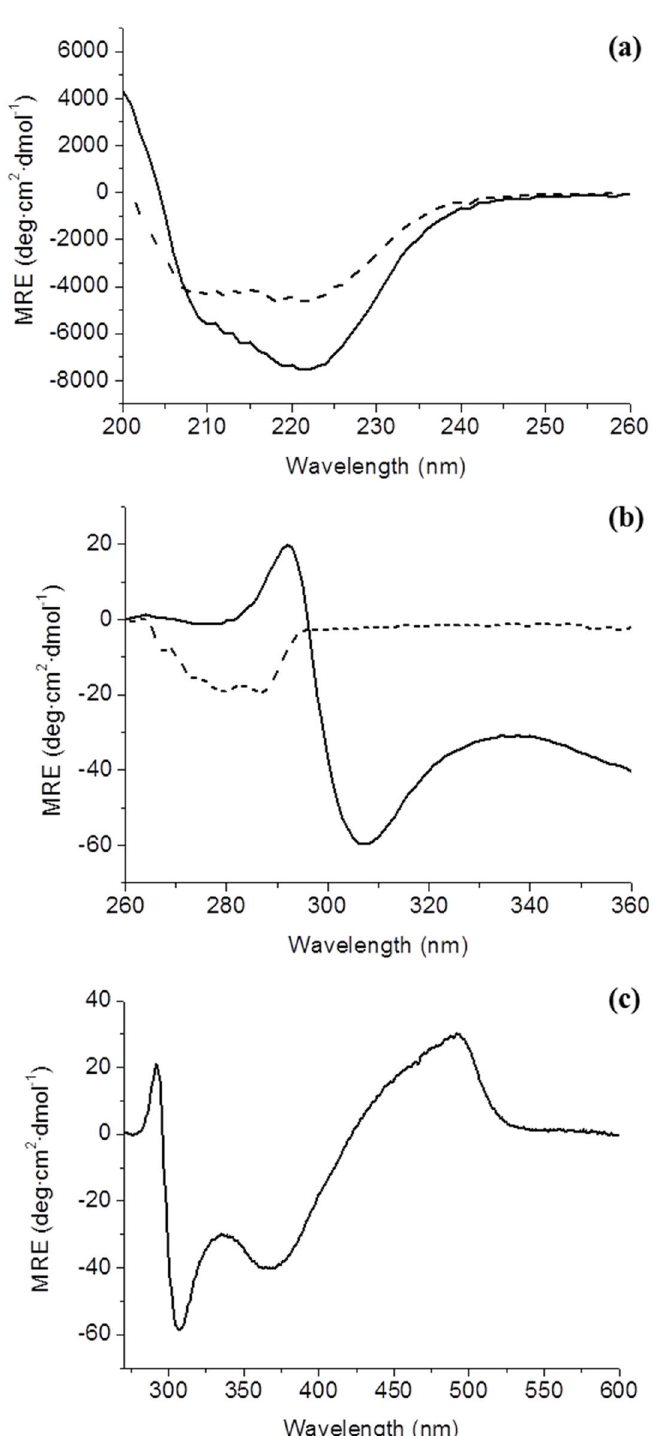
Fig 2. CD spectra of holo and apo Sp Fld in 150 mM NaCl, 100 mM MES, pH 6.5, 4˚C. (a) Far-CD spectra of 80 μ M of holo and apo Sp Fld (continuous and dashedlines respectively) (b) Near-CD spectra of 80 μ M of holo (continuous line) and apo (dashed line) Sp Fld. (c) Visible-CDspectrum of 80 μ M of